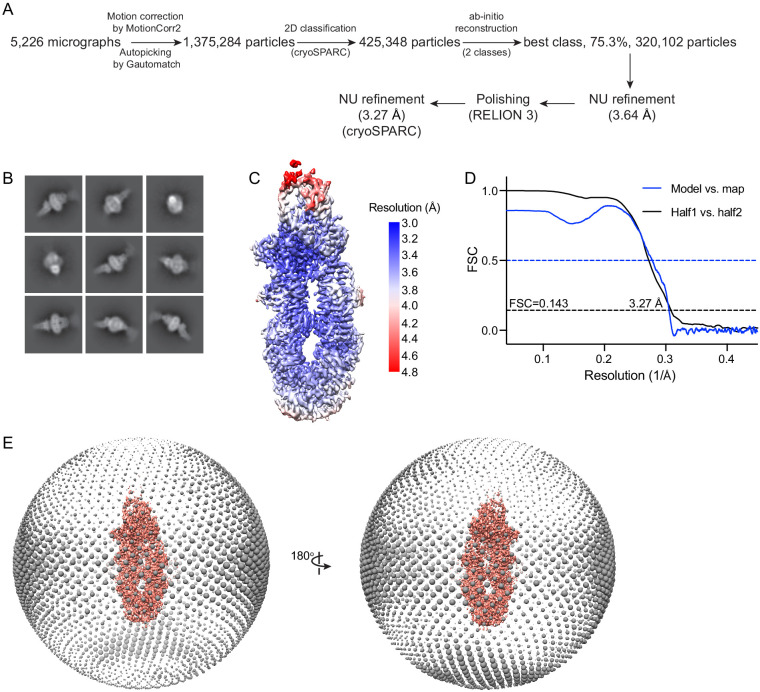
Cryo-electron microscopy reconstructions of the ATP-free, wild-type ABCA4.(A) Summary of the image processing procedure. (B) Representative 2D class averages from cryoSPARC (Punjani et al., 2017). (C) Density map colored by local resolution estimation using RELION 3 (Scheres, 2012; Zivanov et al., 2018). (D) Fourier shell correlation (FSC) plots. Black: half map 1 versus half map 2; blue: model versus summed map. (E) Angular distribution of the particles used in the final reconstruction. Each sphere indicates the number of particles from this angle, and the size of the spheres corresponds to the number of particles.